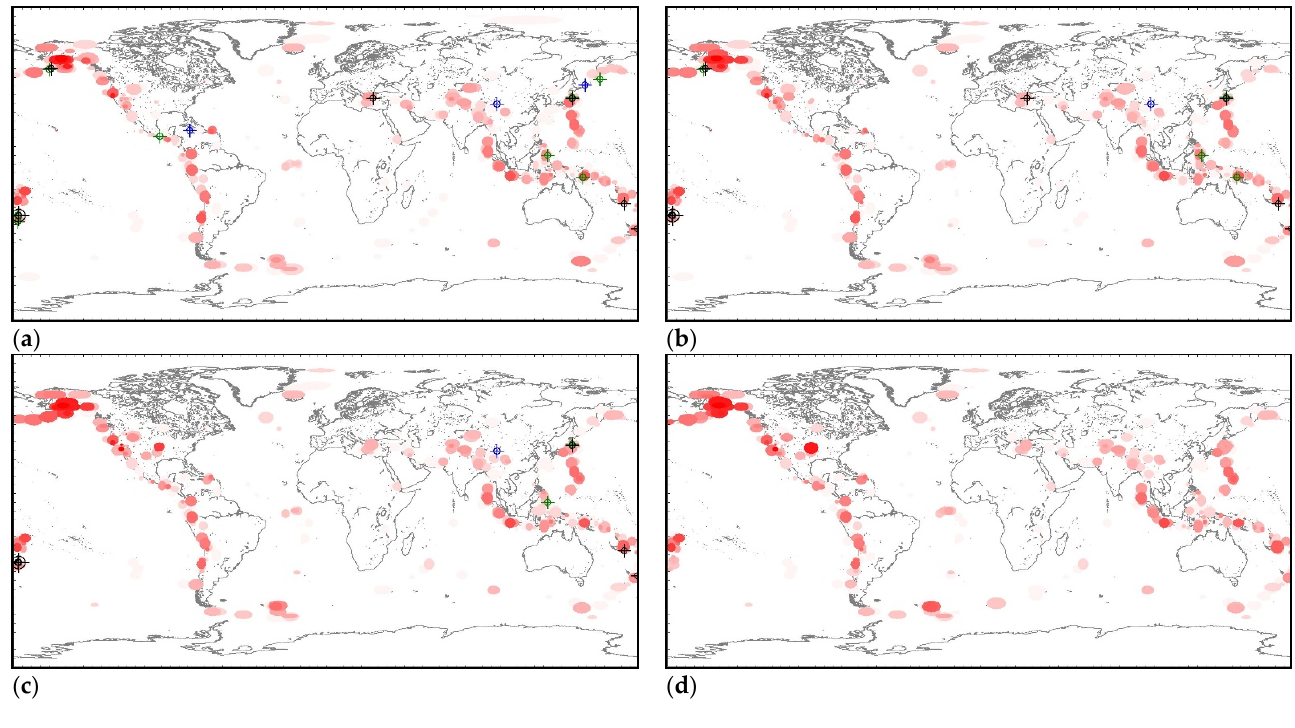
Figure A17. Cluster estimates of the potential hazard of seismic energy flux: 1 January 2020 ( a ), 1 July 2020 ( b ), 1 January 2021 ( c ) and 1 June 2021 ( d ). The cluster color corresponds to the number (the more, the redder) of potentially hazardous unfinished extrapolations found in the cluster. Circles with a crosshair are M7+ earthquakes that occurred after the hazard assessment date before 1 June 2021: black—in identified activity clusters and within the error band of predicted trends (full predictability, Table A12), green—in identified activity clusters with a violation of the error band of trends in the cluster (partially predictability) and blue—unrelated to clusters of potentially hazardous activity (lack of predictability). Table A12. M7+ earthquakes that occurred during the period after the hazard estimation until 1 June 2021 in accordance with the extrapolation of trends in the identified clusters.